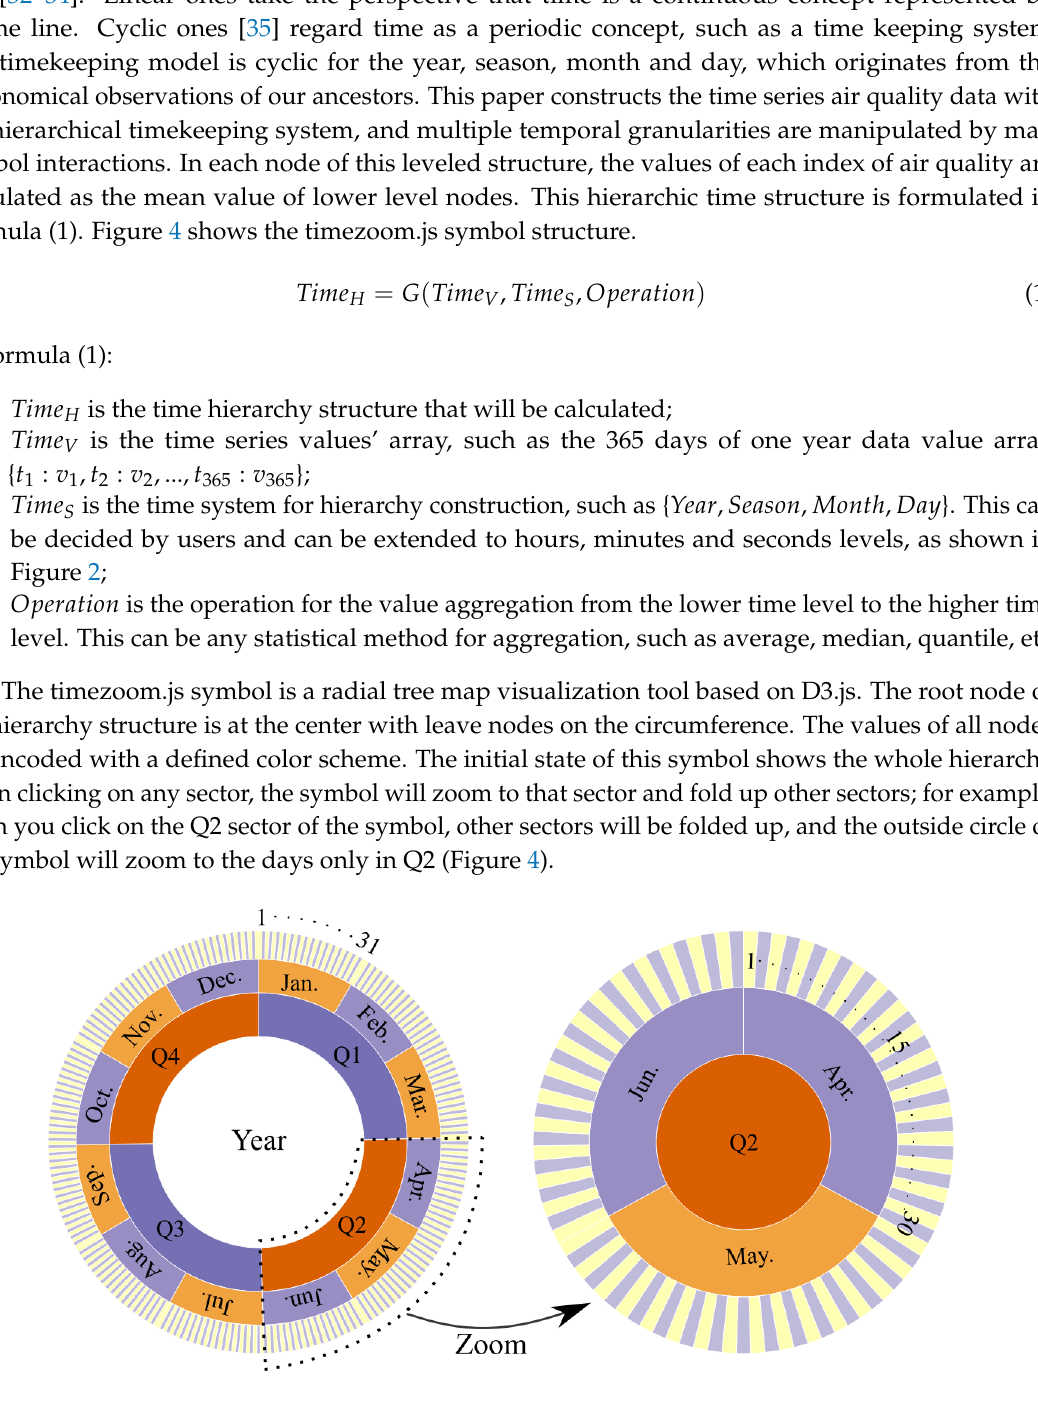
Figure 4. Multi-granularity time zooming interaction (timezoom.js): The inner circle shows the data value of the year, and Sectors Q1, Q2, Q3 and Q4 respectively indicate the four seasonal values and sectors January–December for the monthly data of a year; each month sector is surrounded by daily sectors. Clicking on each sector, the timezoom.js symbol will zoom to that time sector for detailed views of its value